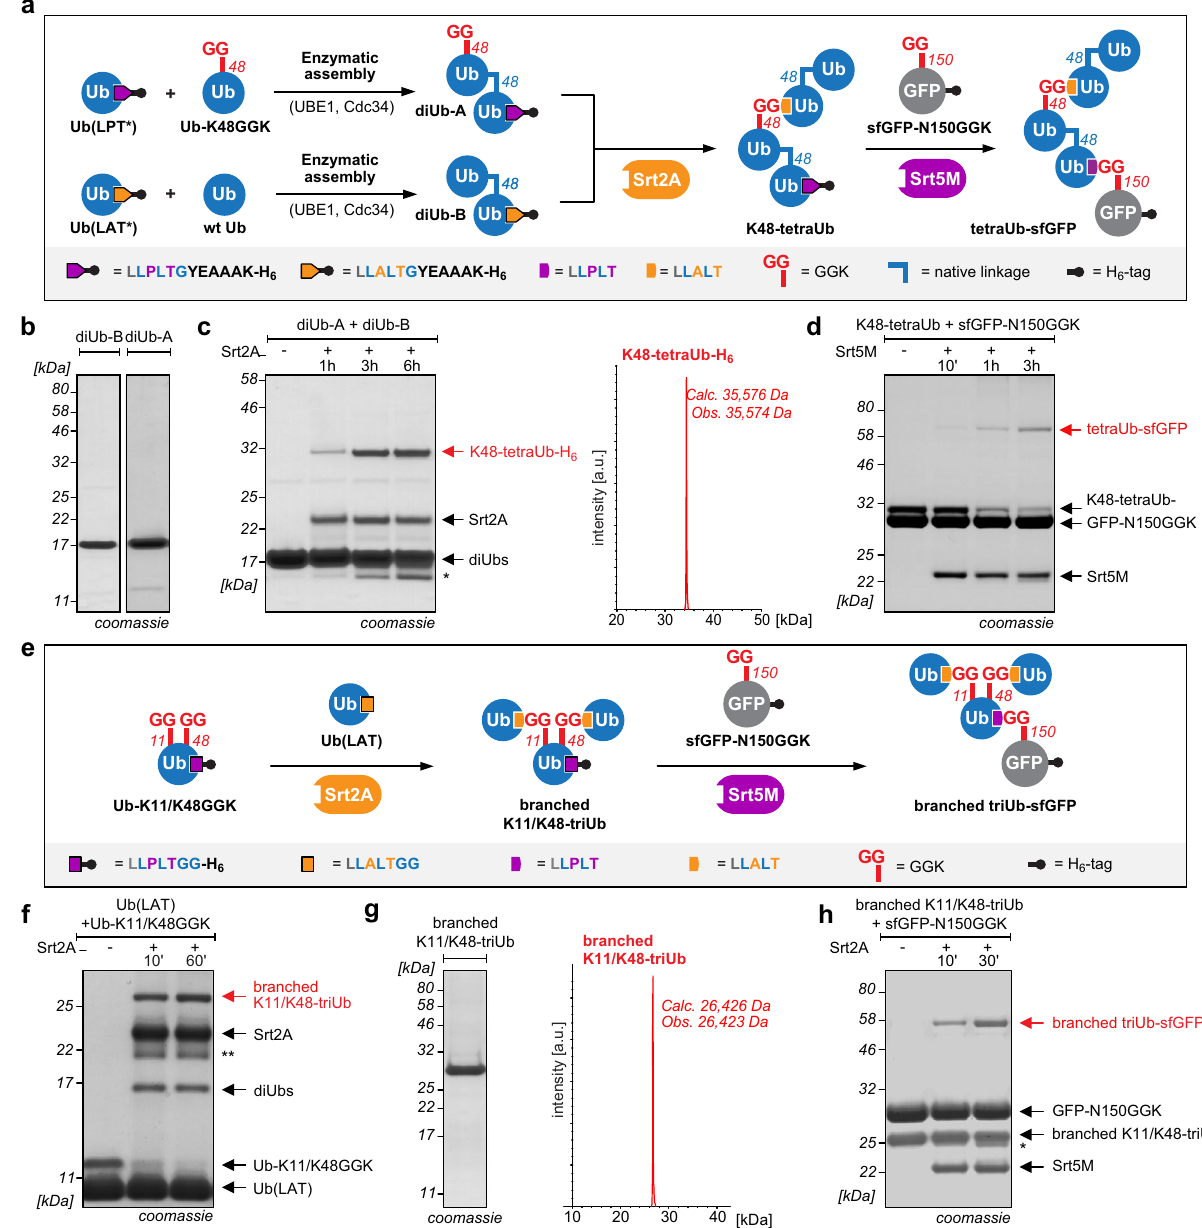
Fig. 5 Generating de fi ned homo- and heterotypic polyUb-POI conjugates. a Combining Ubl-tools with enzymatic Ub assembly allows generation of K48- tetraUb, site-speci fi cally charged onto a protein of interest, here sfGFP. b SDS-PAGE analysis of enzymatically accessed and distinctly modi fi ed K48-linked diUb-A and diUb-B. Full gels as well as LC-MS analysis can be found in Supplementary Fig. 9b, c. c Incubation of diUb-A and diUb-B in the presence of Srt2A leads to formation of K48-tetraUb, as depicted by SDS-PAGE analysis and whose integrity is corroborated by LC-MS. Single asterisk (*) denotes hydrolysis of Srt2A recognition motif and cleavage of H 6 -tag. Full gels and densitometrically determined yields can be found in Supplementary Fig. 10b. d SDS-PAGE analysis showing Srt5M-catalyzed charging of K48-linked tetraUb onto sfGFP-N150GGK. Densitometric analysis revealed formation of tetraUb-sfGFP formation in 45% yield. e Schematic representation showing Ubl-tools generated branched Ub chains (K11/K48 branched) and their site- speci fi c attachment to a POI. f SDS-PAGE analysis displaying the formation of K11/K48-branched triUb by incubation of Ub-K11/K48GGK with Ub(LAT) and Srt2A. Double asterisks (**) denote an impurity in the Srt2A-stock. Full gels and densitometrically determined yields can be found in Supplementary Fig. 13b. g Integrity of puri fi ed K11/K48-branched triUb is shown by SDS-PAGE analysis and LC-MS. h Incubation of K11/K48-branched triUb with sfGFP- N150GGK in presence of Srt5M leads to the formation of de fi ned branched triUb-sfGFP conjugate. Single asterisk (*) denotes hydrolysis of Srt5M recognition motif and cleavage of H 6 -tag. Densitometric analysis revealed branched triUb-sfGFP formation with 33% yield. Consistent results were obtained over at least three replicate experiments. Source data are provided as a Source Data fi